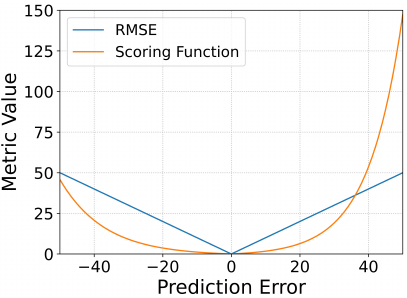
Figure 3. Comparison between RMSE and the scoring